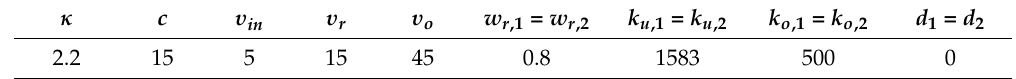
Table A5. Wind speed